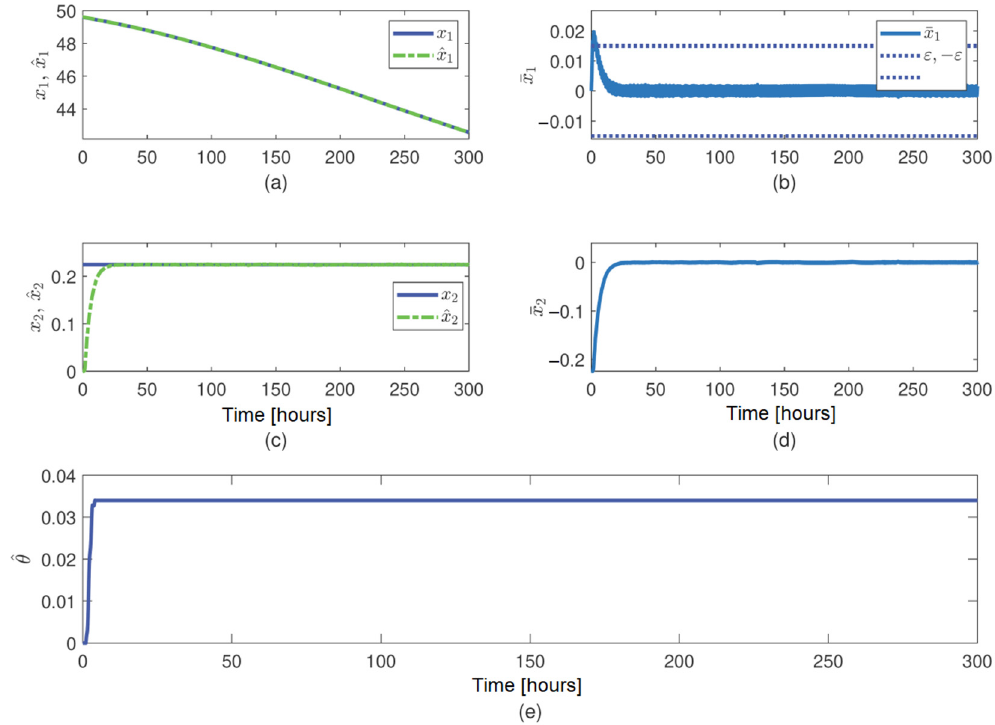
Figure 3. Performance of the proposed observer in the first simulation example: ( a ) trajectory of state x 1 and estimate ˆ x 1 ; ( b ) trajectory of the observer error for the known state, x 1 ; ( c ) trajectory of state x 2 and estimate ˆ x 2 ; ( d ) trajectory of the observer error for the unknown state, x 2 ; ( e ) trajectory of the updated parameter ˆ θ b